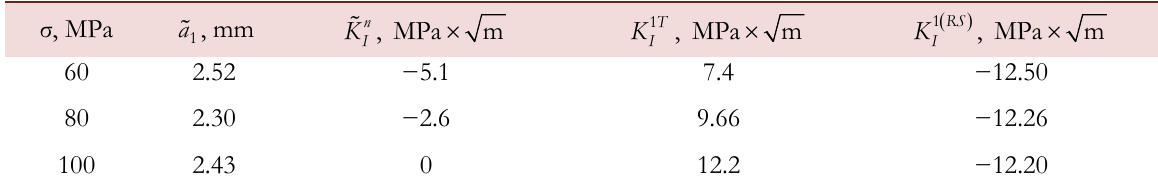
Table 4: SIF values for different remote stress